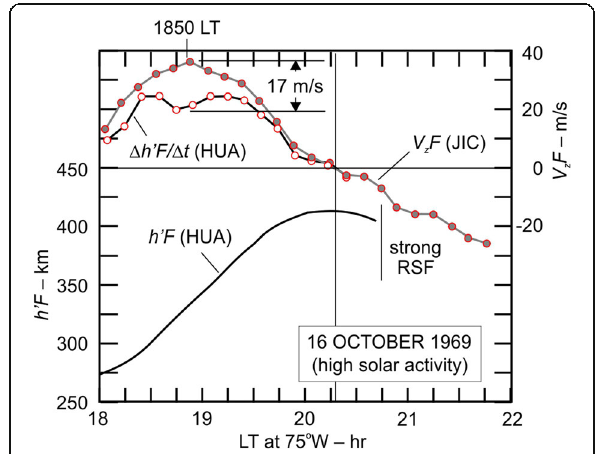
Fig. 3 Direct comparison of Δ h ’ F/ Δ t measured over HUA and V z F measured with the JIC radar, plotted versus LT. [Points were scaled and replotted from Fig. 1 in Rastogi et al.